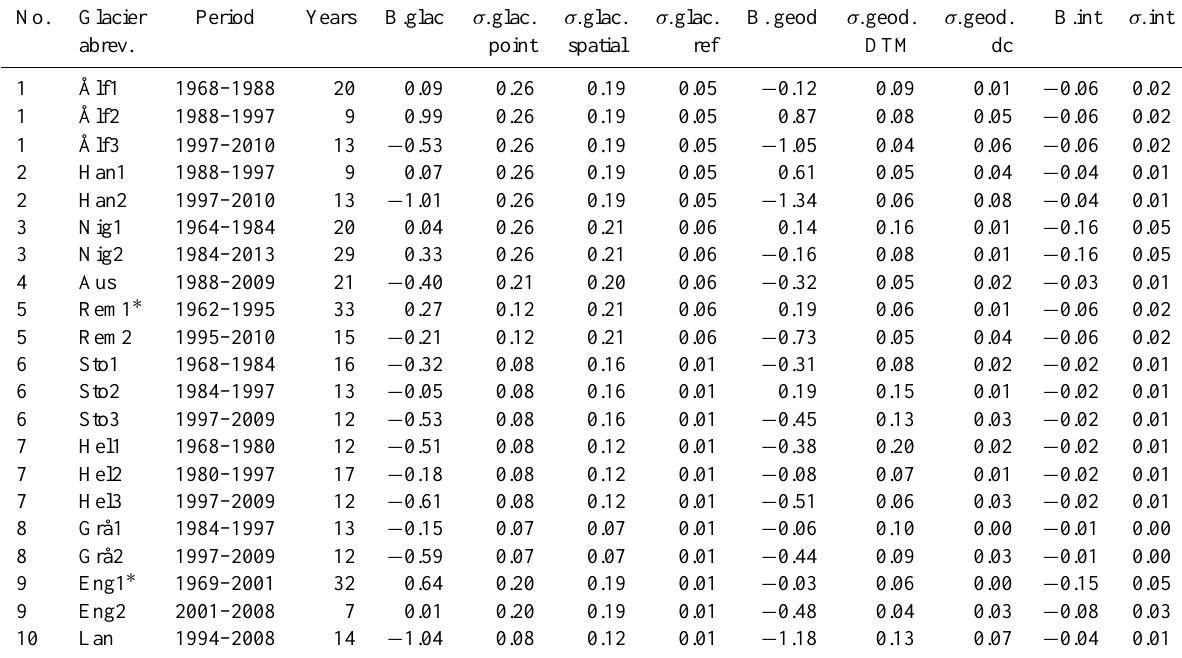
Table 4. Results of the mass balances and the uncertainty analysis for the 10 glaciers and 21 periods studied. Glacier names are shown with three characters as in Fig. 1. Numbers are added for glaciers with multiple geodetic periods. B is (glaciological, geodetic, and internal) mass balance and σ is the estimated random error ( ± ) for the three balances. See Sect. 3.4.1. for explanation of terms. All mass balances and errors are in mw.e.a − 1